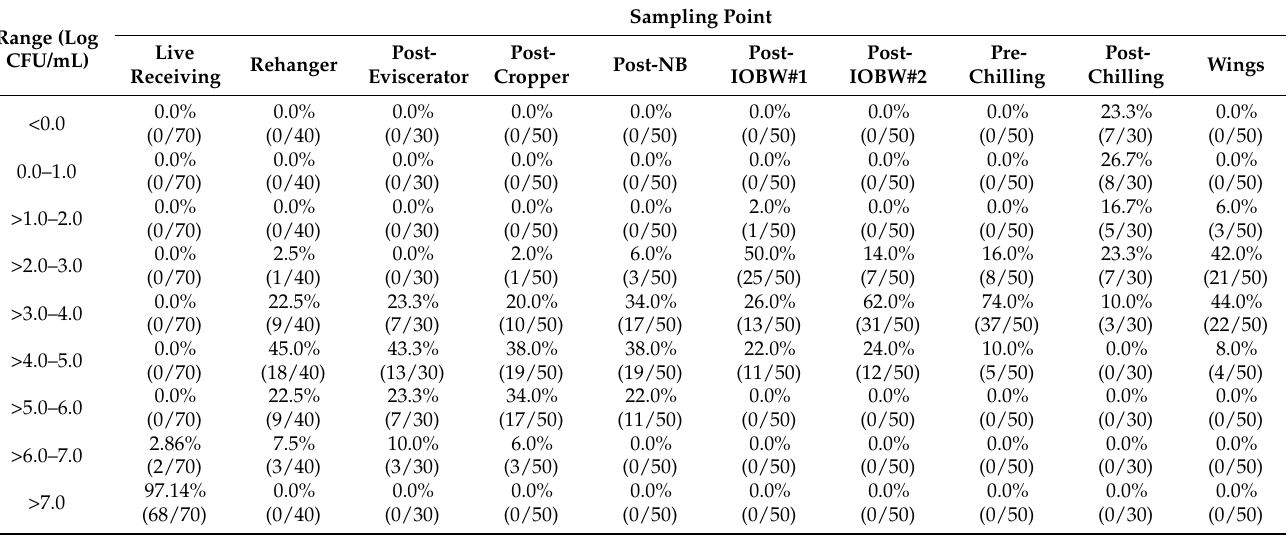
Table A3. Distribution of aerobic counts (Log CFU/mL) on each of the ten sampling locations under normal process intervention on chicken and part rinses (n = 470 samples).